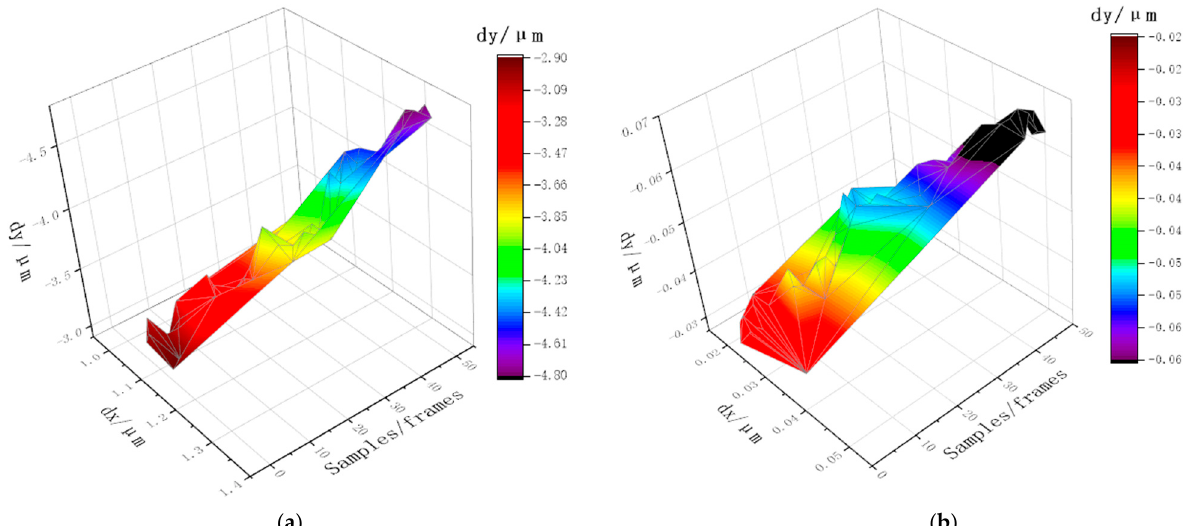
Figure 14. Cumulative errors before and after compensation. ( a ) before, ( b ) after.